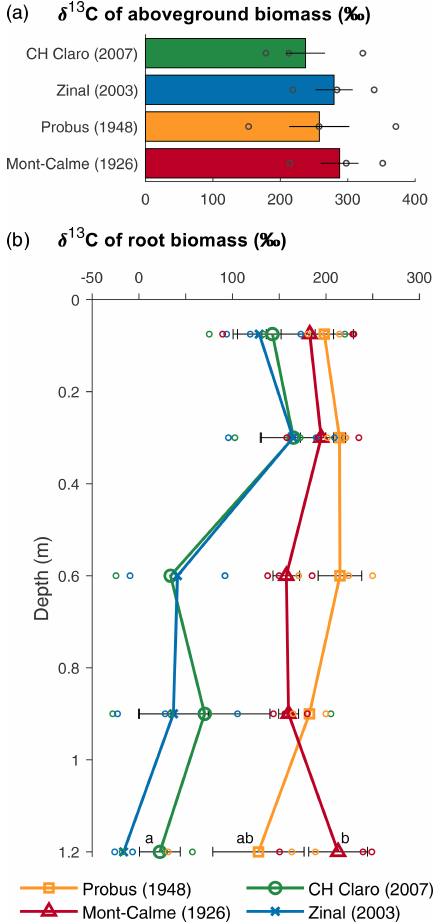
Figure 2. δ 13 C values of aboveground (a) and belowground (b) biomass for the different wheat cultivars at the end of the exper- iment. Bars (a) and symbols (b) represent the average per wheat cultivar, error bars show the standard error ( n = 3), and symbols without error bars indicate samples for which no three replicates were available. Circles show the individual data points. If statisti- cally significant differences were present for root biomass at the same depth, these are indicated with letters, with variables sharing a letter not being significantly different and data points without error bars being left out of the